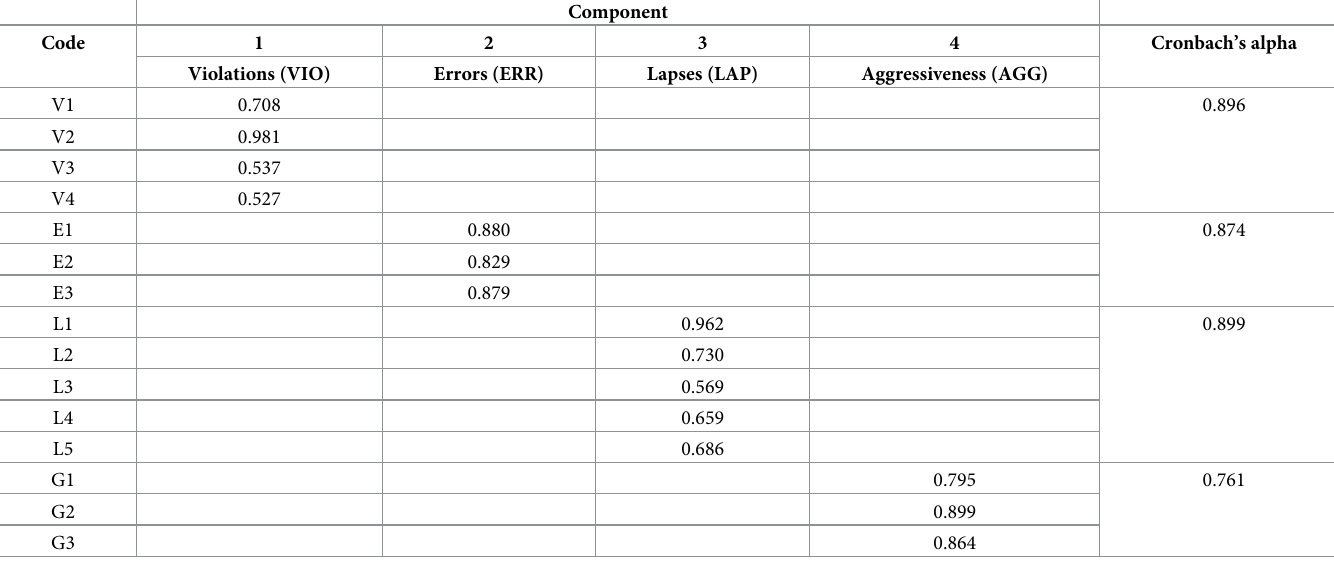
Table 5. Risky behavior results of EFA; KMO =